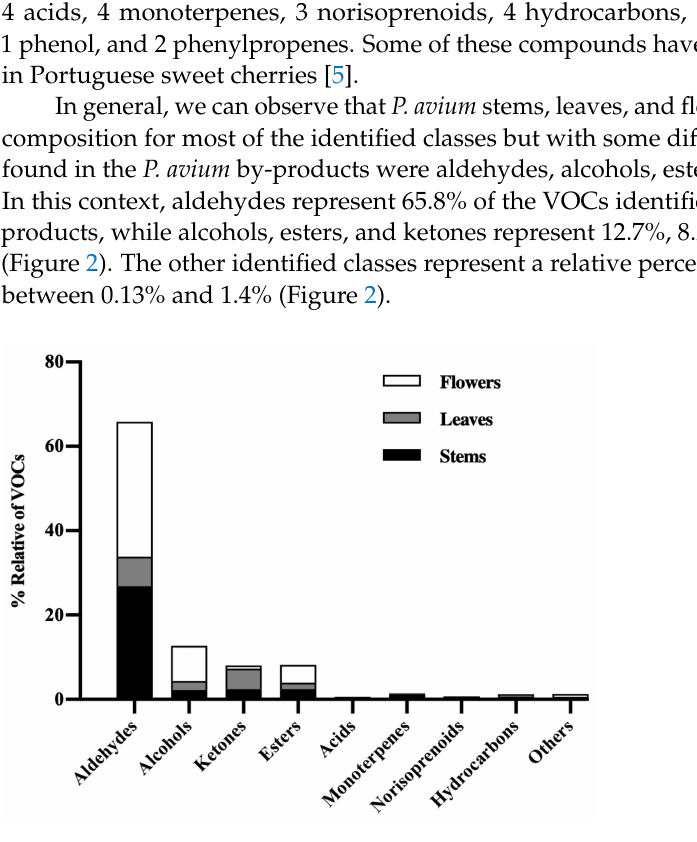
Figure 2. Percentage of the total volatile organic compounds (VOCs) represented by the different classes of compounds in the Prunus avium L. stems, leaves, and flowers from the Saco variety. Stem hydroethanolic extracts showed the highest diversity of aldehydes (17 of 31 compounds), while flower hydroethanolic extracts exhibited the highest number of esters (18 of 30 compounds). Ketones were found mainly in the stem crude extract and leaf and flower aqueous infusions (6 of 16 compounds). On the other hand, the stem and leaf aqueous infusions presented the greatest variety of alcohols (7 of 14